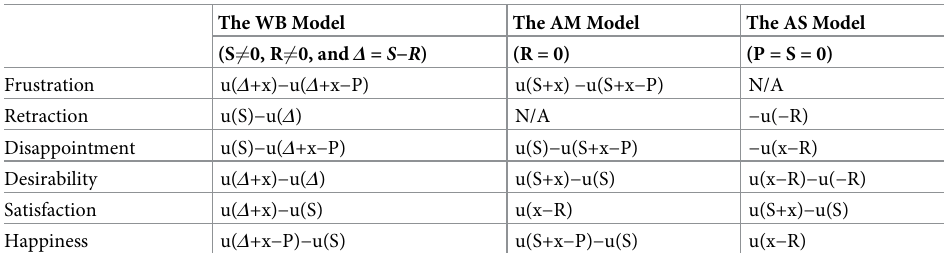
Table 2. Measurements in the AM, AS, and WB